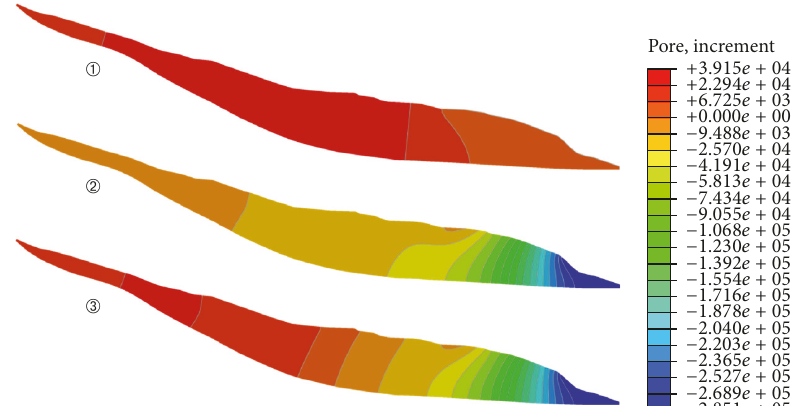
Figure9:Porewaterpressureincrementunderdifferentboundaryconditions: A onlyrainfallconsidered; B onlyreservoirwaterleveldecline considered; C the coupling of rainfall and reservoir water level decline (unit, Pa).